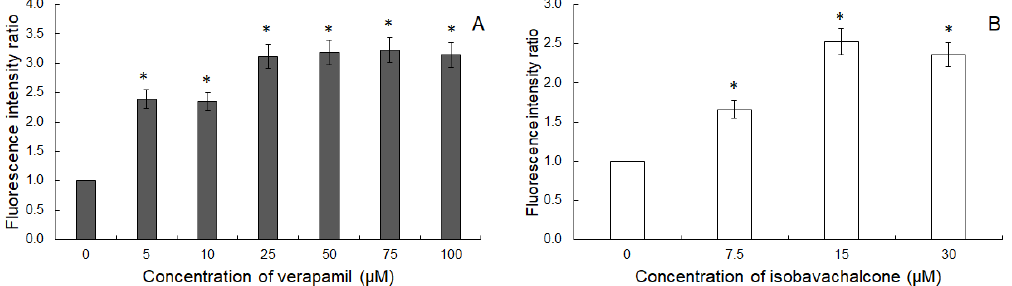
Figure 4. Intracellular accumulation of R123 in MDCK-MDR1 cells treated with Ver ( A ) and IBC ( B ). Means ± SD of three experiments are presented. The statistically significant differences from the untreated cells were determined using Student’s t -test (* p < 0.05).